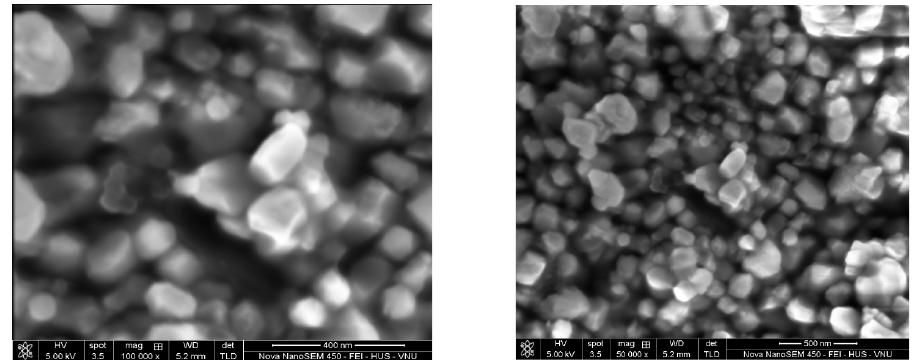
Figure 6. SEM images of ZrO 2 nanoparticles after L.L.E by D2EHPA/p ‐ xylenes.